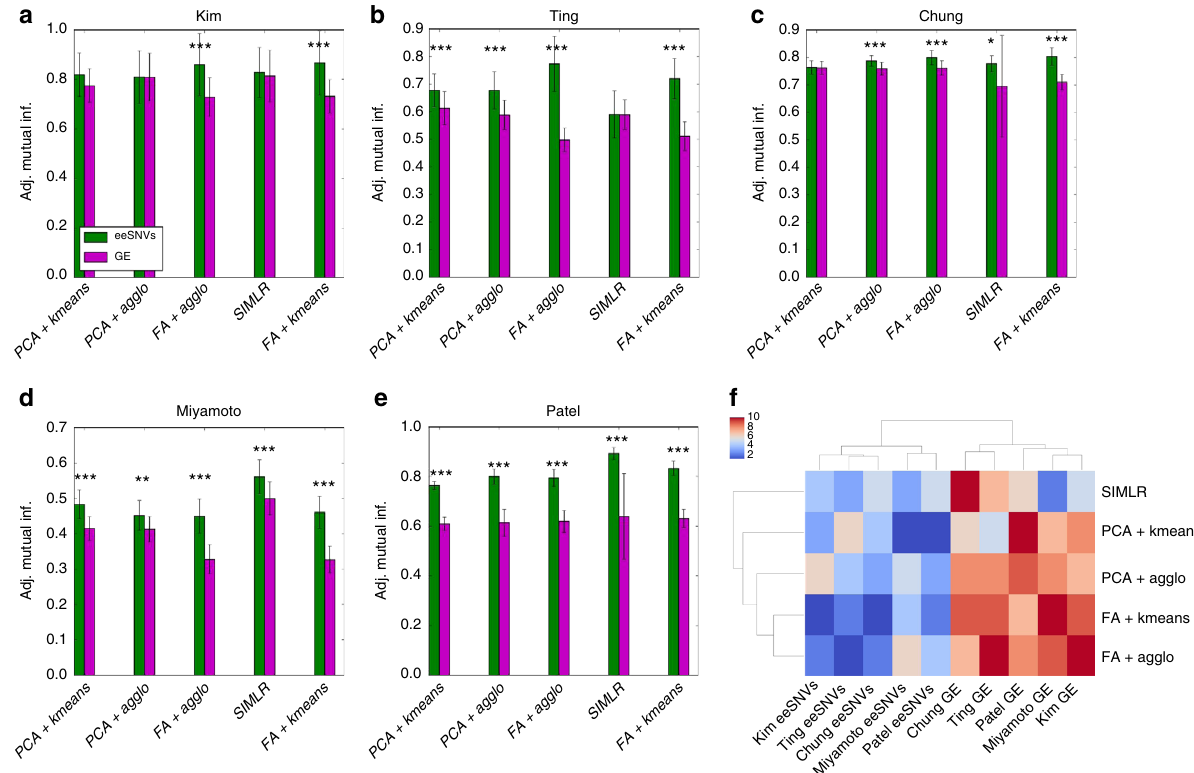
Fig. 2 Comparison of clustering accuracy using eeSNV and gene expression (GE) features. a – e Bar plots comparing the clustering performance using eeSNV vs. gene expression (GE) as features, over fi ve different clustering strategies and fi ve datasets, each with its own pre-de fi ned classes as the truth measure: a Kim dataset, b Ting dataset, c Chung dataset, d Miyamoto dataset, and e Patel dataset. Y -axis is the adjusted mutual information (AMI) obtained across 30 bootstrap runs (mean ± s.d.). Error bars represent standard deviation. * P < 0.05, ** P < 0.01, and *** P < 0.001 (paired t -test). f Heatmap of the rankings among different methods and datasets as shown in a –